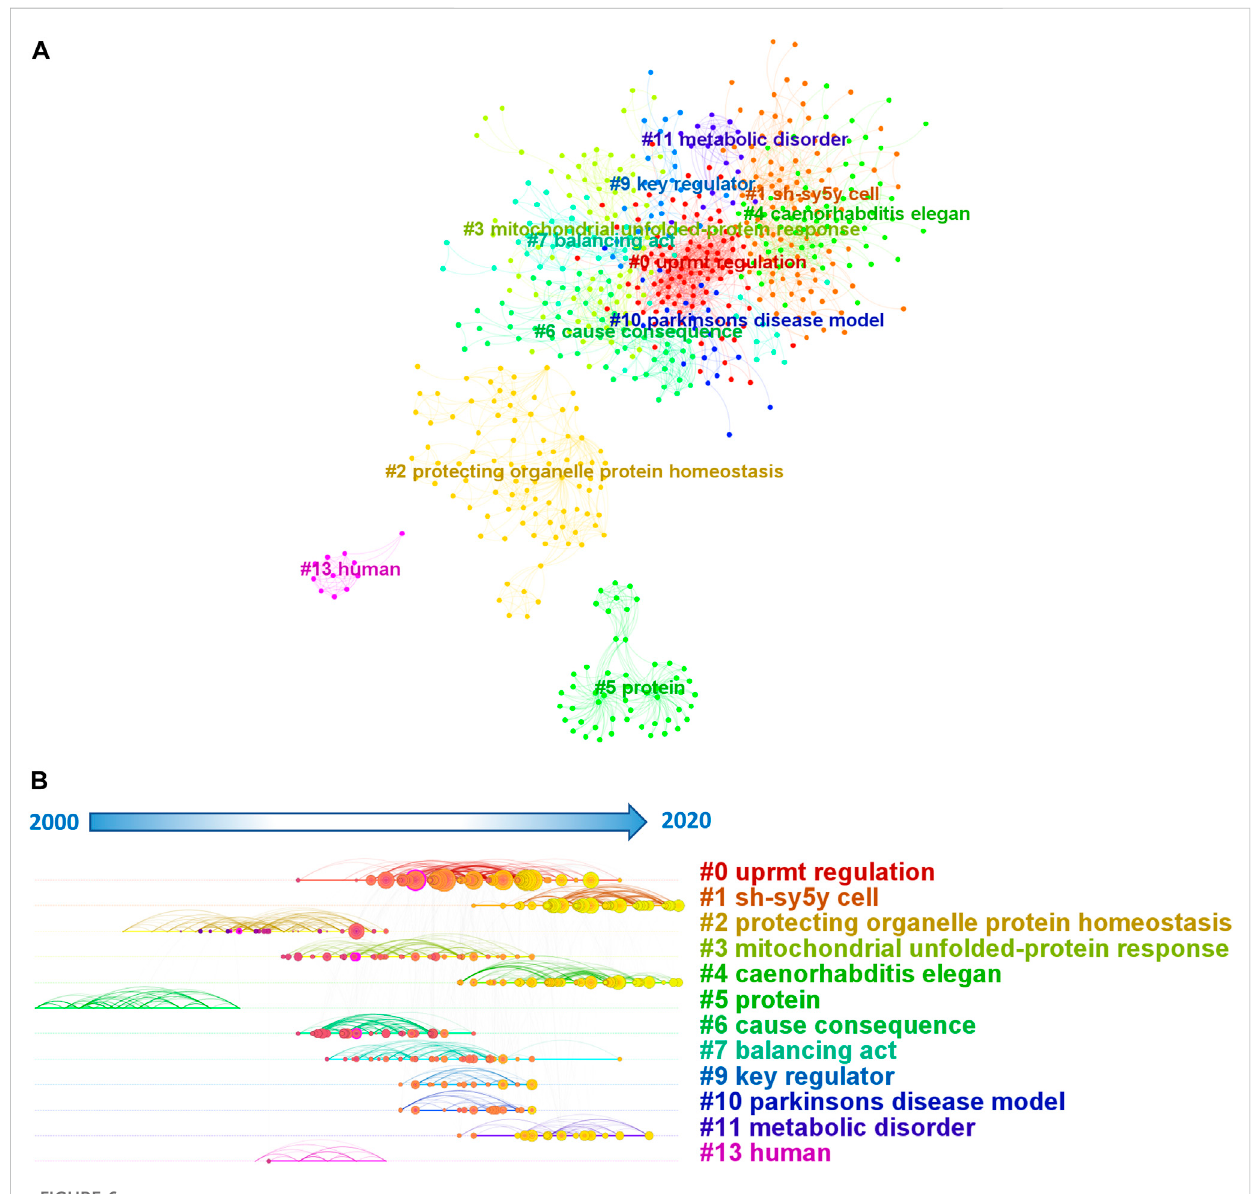
Co-citation network (A) and timeline view (B) in UPR mt